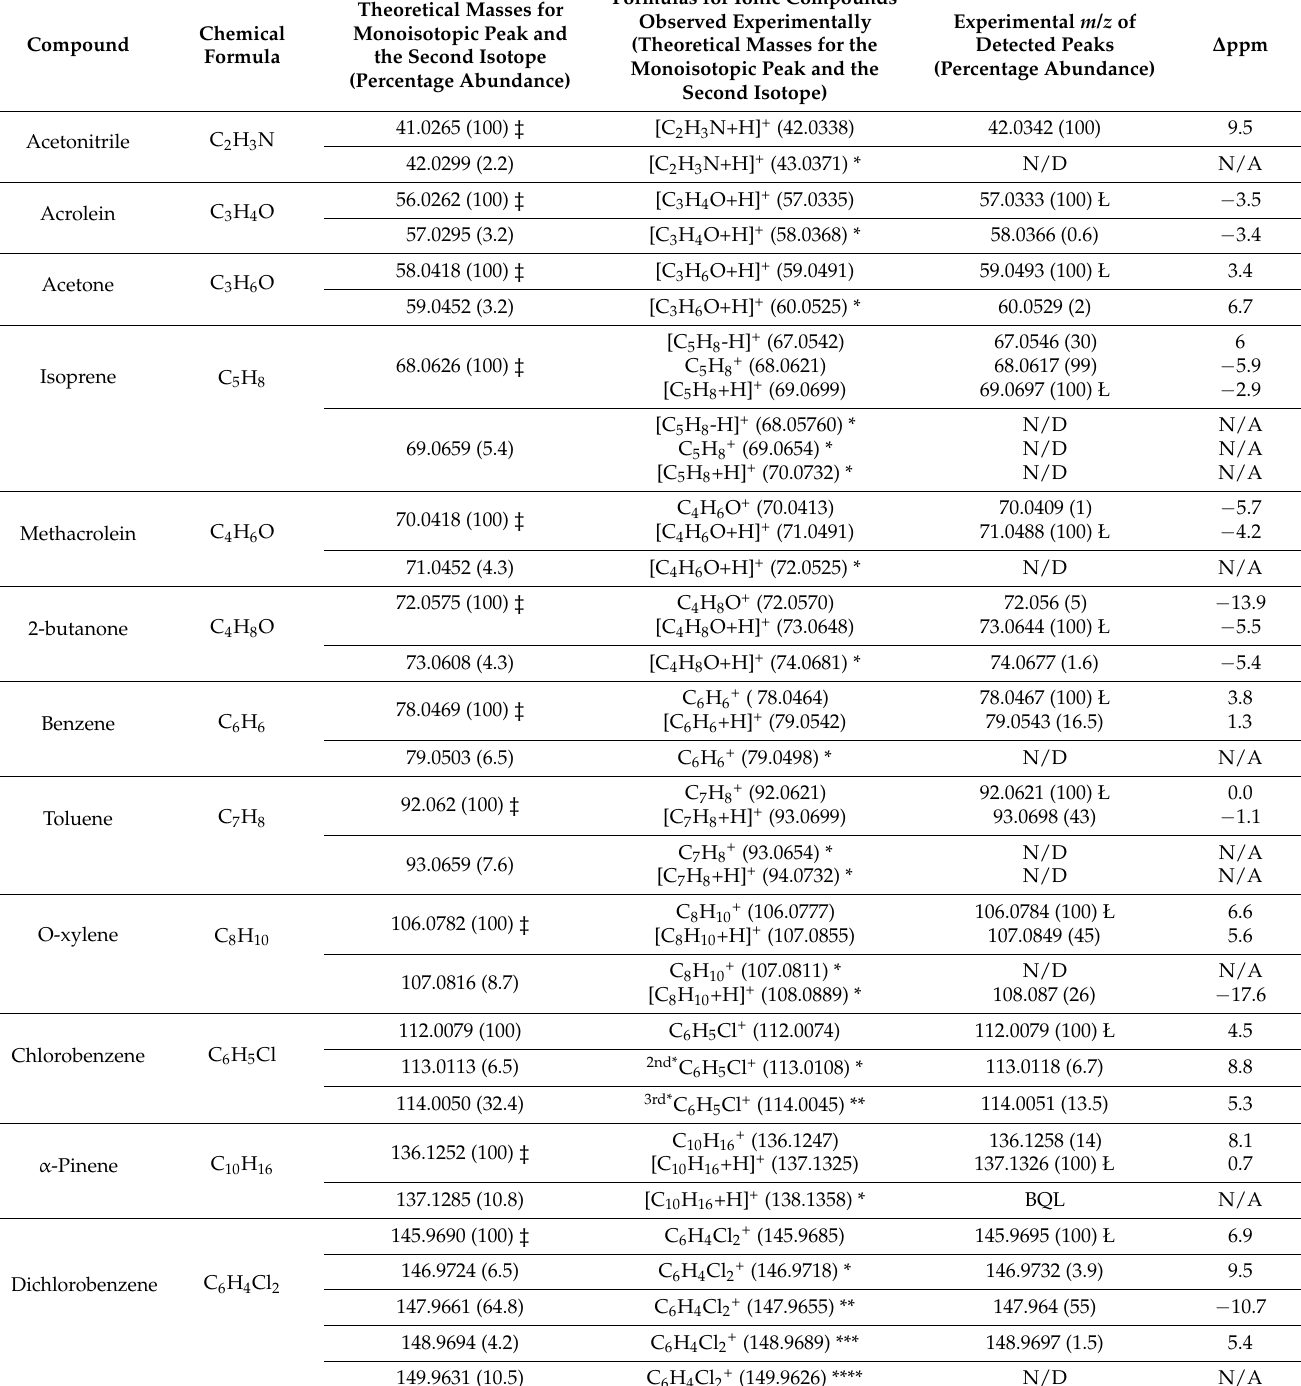
‡ monoisotopic peak. Ł peak used for calibration. *: second isotope of compound. **: third isotope of compound. ***: fourth isotope of compound. ****: fifth isotope of compound. N/D: not detected. N/A: not available. BQL: Below quantification